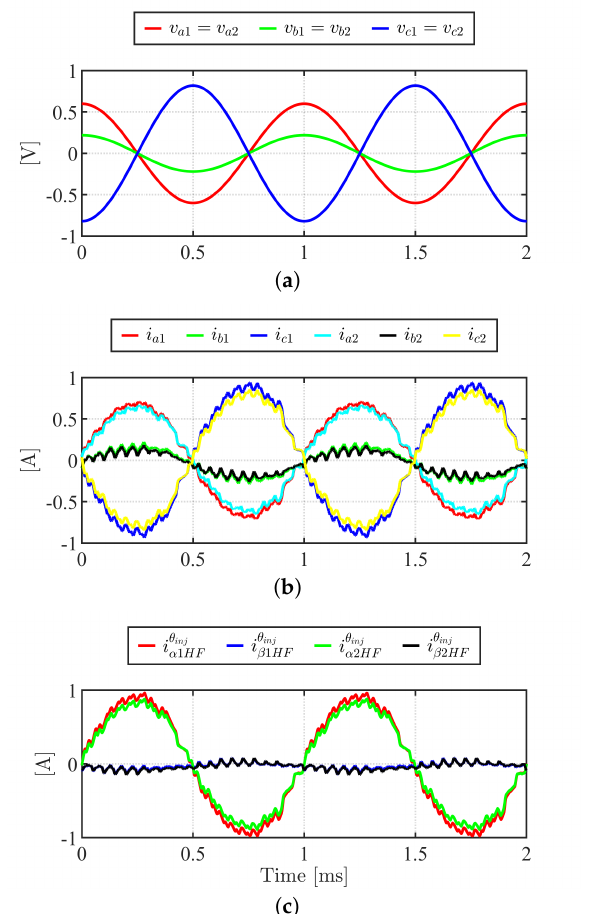
Figure 12. HF pulsating voltage injection and current response, x = 0 mm, y = − 1 mm. ( a ) HF phase voltage command, abc 1 and abc 2 ; ( b ) HF phase current response, abc 1 and abc 2 ; ( c ) HF current θ inj θ inj θ inj θ inj response of i , i , i , and i α 2 HF α 1 HF β 1 HF β 2 HF